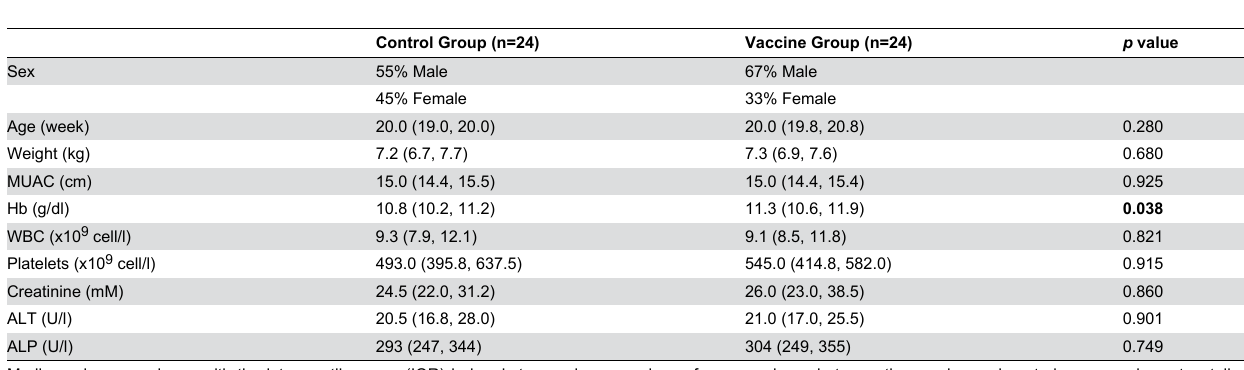
Table 2. Baseline characteristics of study